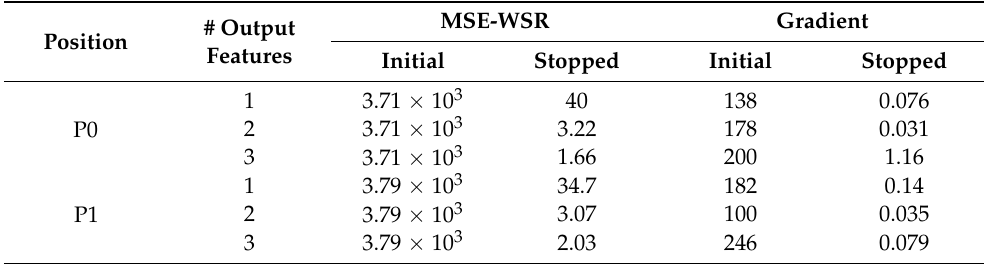
Table 7. Autoencoder performance in generating latent features from original input features for positions P0 and P1; ‘#’ denotes the number of features.